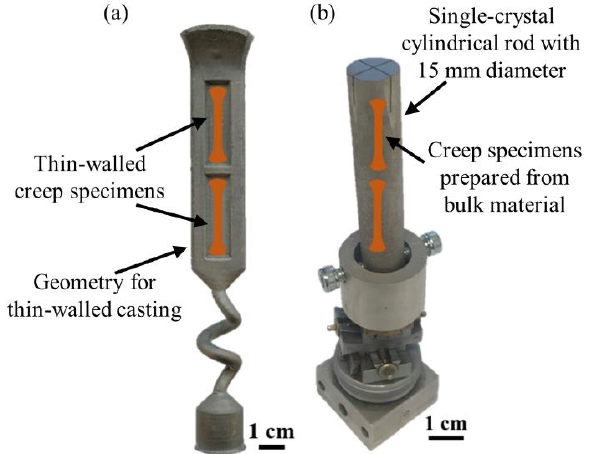
Figure 1. Casting geometry and schematic illustration of creep specimen preparation for ( a ) thin- walled castings and ( b ) single-crystal cylindrical rod.